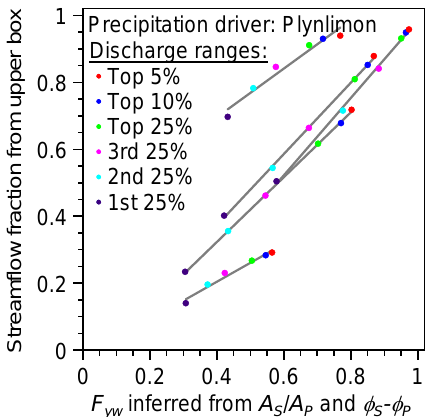
Figure 13. Correlations between flow-weighted young water frac- tions F yw and fractional contributions of the upper box to stream- flow across different discharge ranges, for five parameter sets illus- trating the diversity of relationships that can arise in the model. The upper box contribution is strongly correlated with F yw in all cases, although the slopes and the intercepts vary among parameter